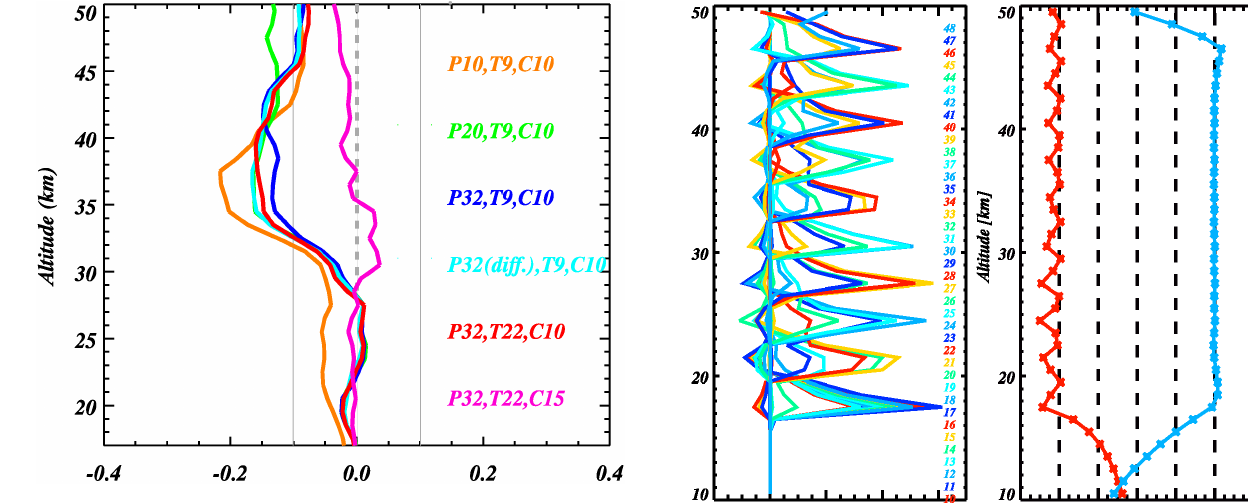
Fig. 10. The LBL–ESFT comparison for the year 2008: ESFT re- trieval performed at different grids with different pressure, tem- perature, and number of coefficients and compared with LBL. The results are shown as the relative mean differences, i.e. mean (LBL-ESFT)/LBL.